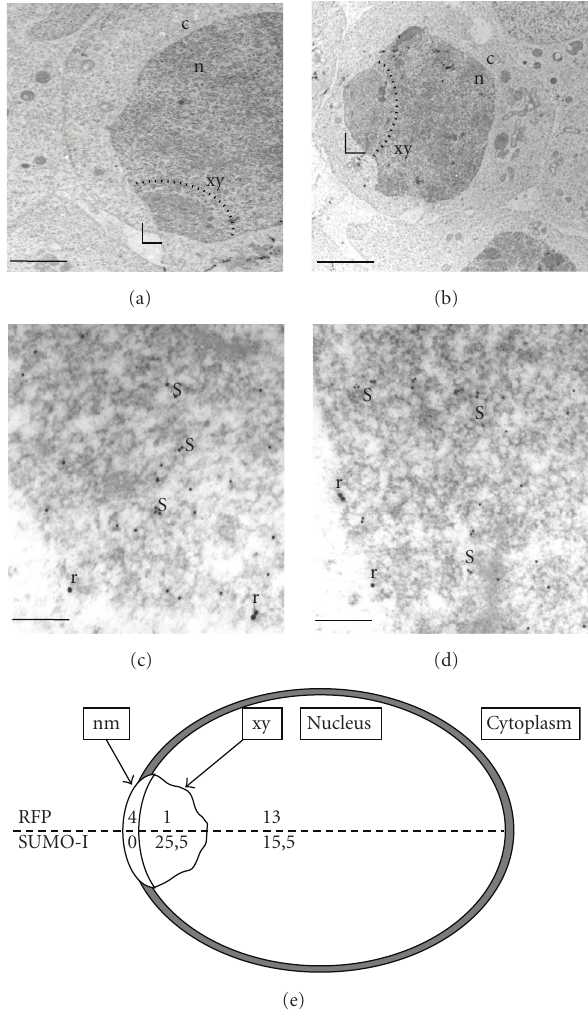
Figure 3: Subcellular localization of RFP and SUMO-I in pachytene spermatocyte nucleus. (a), (b) Overviews of pachytene cells in adult mouse testis (bar, 4 μ m). XY body (xy) in the nucleus (n) is underlined by the dotted line (c, cytoplasm). The indicated part of the XY body ( ) is enlarged in panels (c) and (d), respectively. (c), (d) RFP and SUMO-I coimmunolabeling detected using gold particles of two di ff erent sizes: 15 nm for RFP and 10nm for SUMO-1 (bar, 160 nm). RFP (r) is significantly concentrated at the border of the nucleus adjacent to the XY body labeled by SUMO-I (s). (e) Nucleus, XY body, and nuclear membrane have been schematized respecting relative size (excepted for nuclear membrane). Mean of beads count is indicated in the correspond- ing area (nm, nuclear membrane facing the XY body, xy: XY